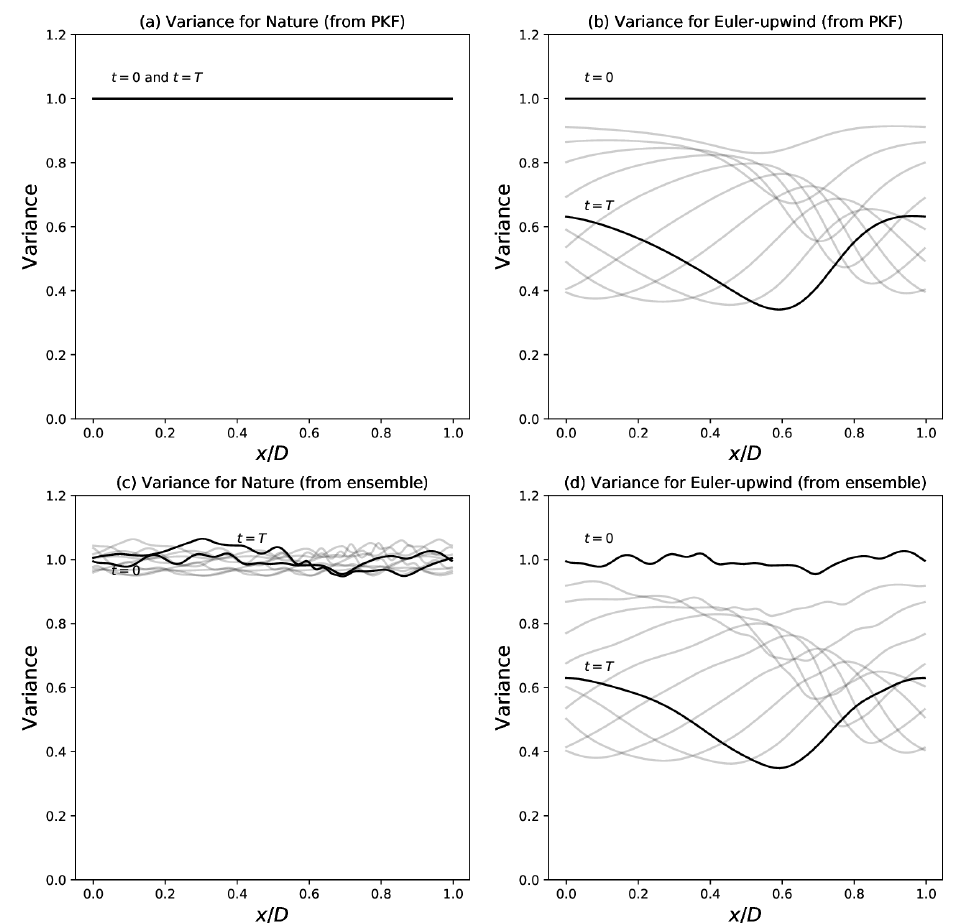
Figure 4. Predictability-error variance field, (cid:101) V p (t,x) , for the nature (Eq. 30), computed from the PKF (Eq. 36) (a) and predictability-error variance field, V p (t,x) , for the numerical model resulting from the finite-difference and Euler discretization equation (Eq. 37), computed from the PKF (Eq. 40) (b) . Panels (c) and (d) are the ensemble estimation for panels (a) and (b) , where the nature dynamics is approximated by Eq. (46) dynamics in panel (c) (6400 members are used here). Fields are represented for times from t = 0 to t = T and represented each 0 . 1 T